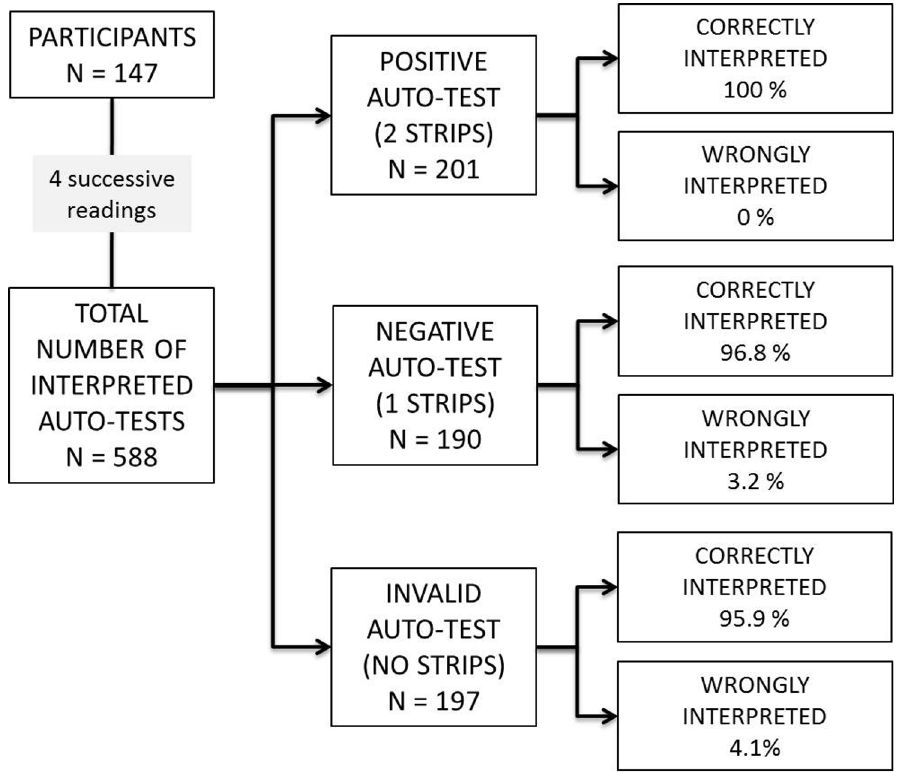
Fig 2. Ability of participants to read and interpret the HIV self-test results using a chart from a panel of 6 standardized tests.